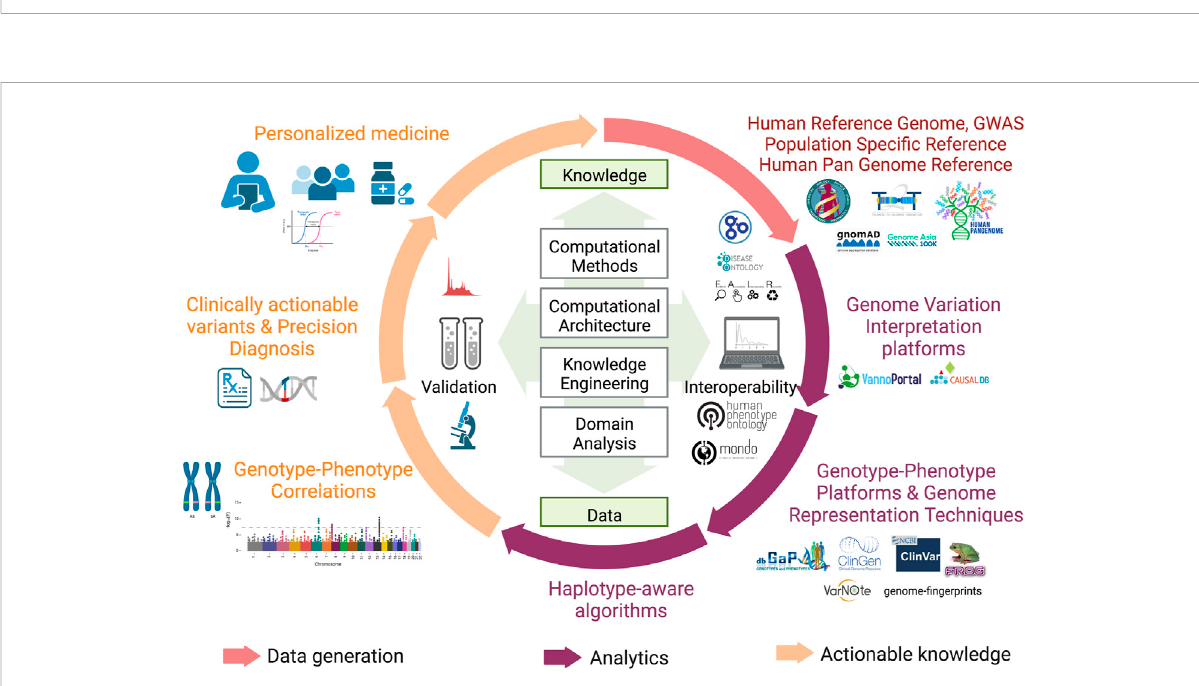
FIGURE 2 Overview of approaches for biomedical applications of human genome studies. Adapted from “ The Clinical Applications of Translational Bioinformatics ” , by BioRender.com (2022). Retrieved from https://app.biorender.com/biorender-templates.